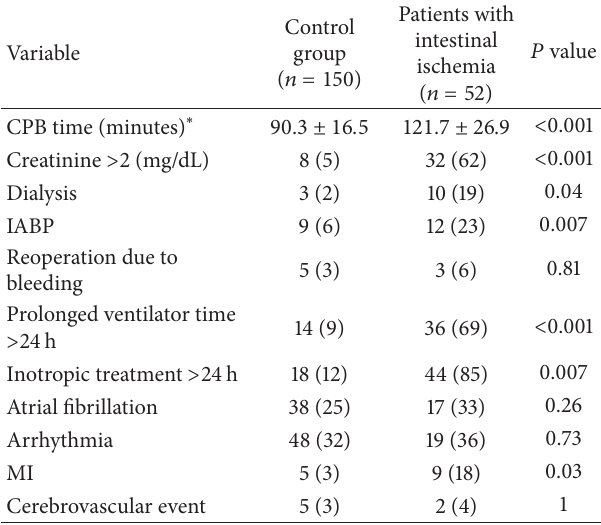
Table 2: Perioperative values for intestinal ischemia after cardiac surgery.